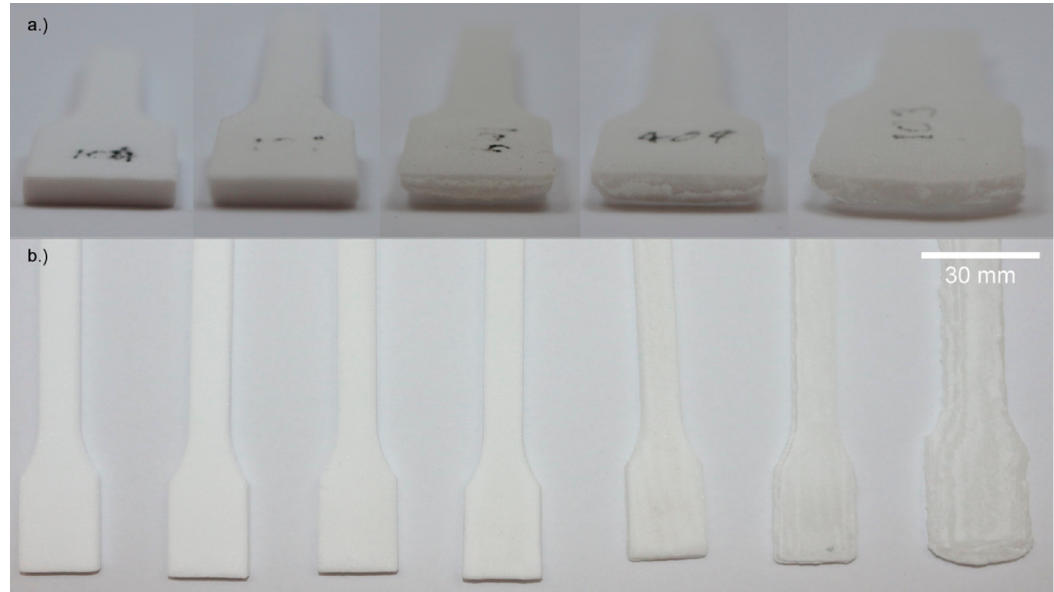
Figure 4. Optical micrographs of tensile test specimen. ( a ) Front perspective, from left to right with 5, 20, 25, 30, and 45% BL; ( b ) top perspective, from left to right with 5, 10, 15, 20, 25, 30, and 45% BL.